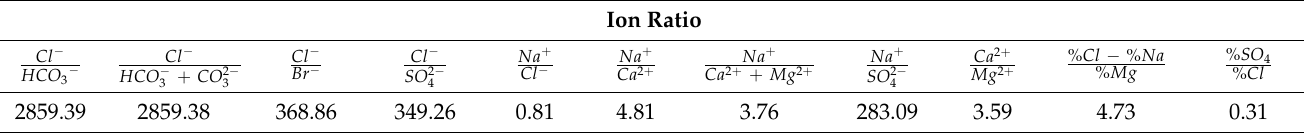
Table 2. Average hydrochemical indicators.